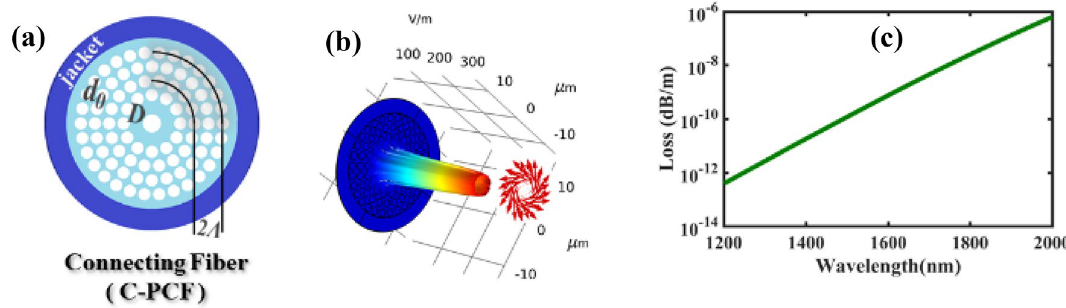
Figure 4. ( a ) The cross-section of the connecting C-PCF with the center air hole diameter of D = 2.4 µm, cladding air hole diameter of d = 1.6 µm and the pitch size of Λ = 2 µm; ( b ) the cylindrical intensity profile of the TE 01 mode; and ( c ) very low confinement loss spectrum of the TE 01